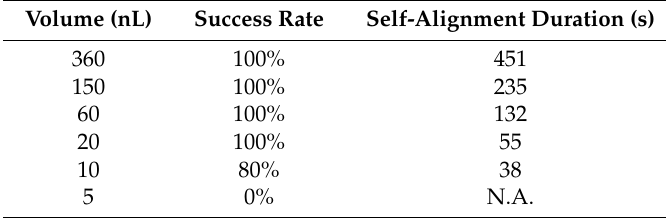
Table 1. Influence of volume of droplet on capillary self-alignment.